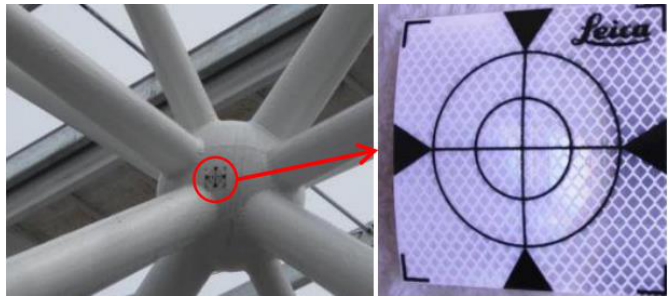
Figure 12. Deformation monitoring points.